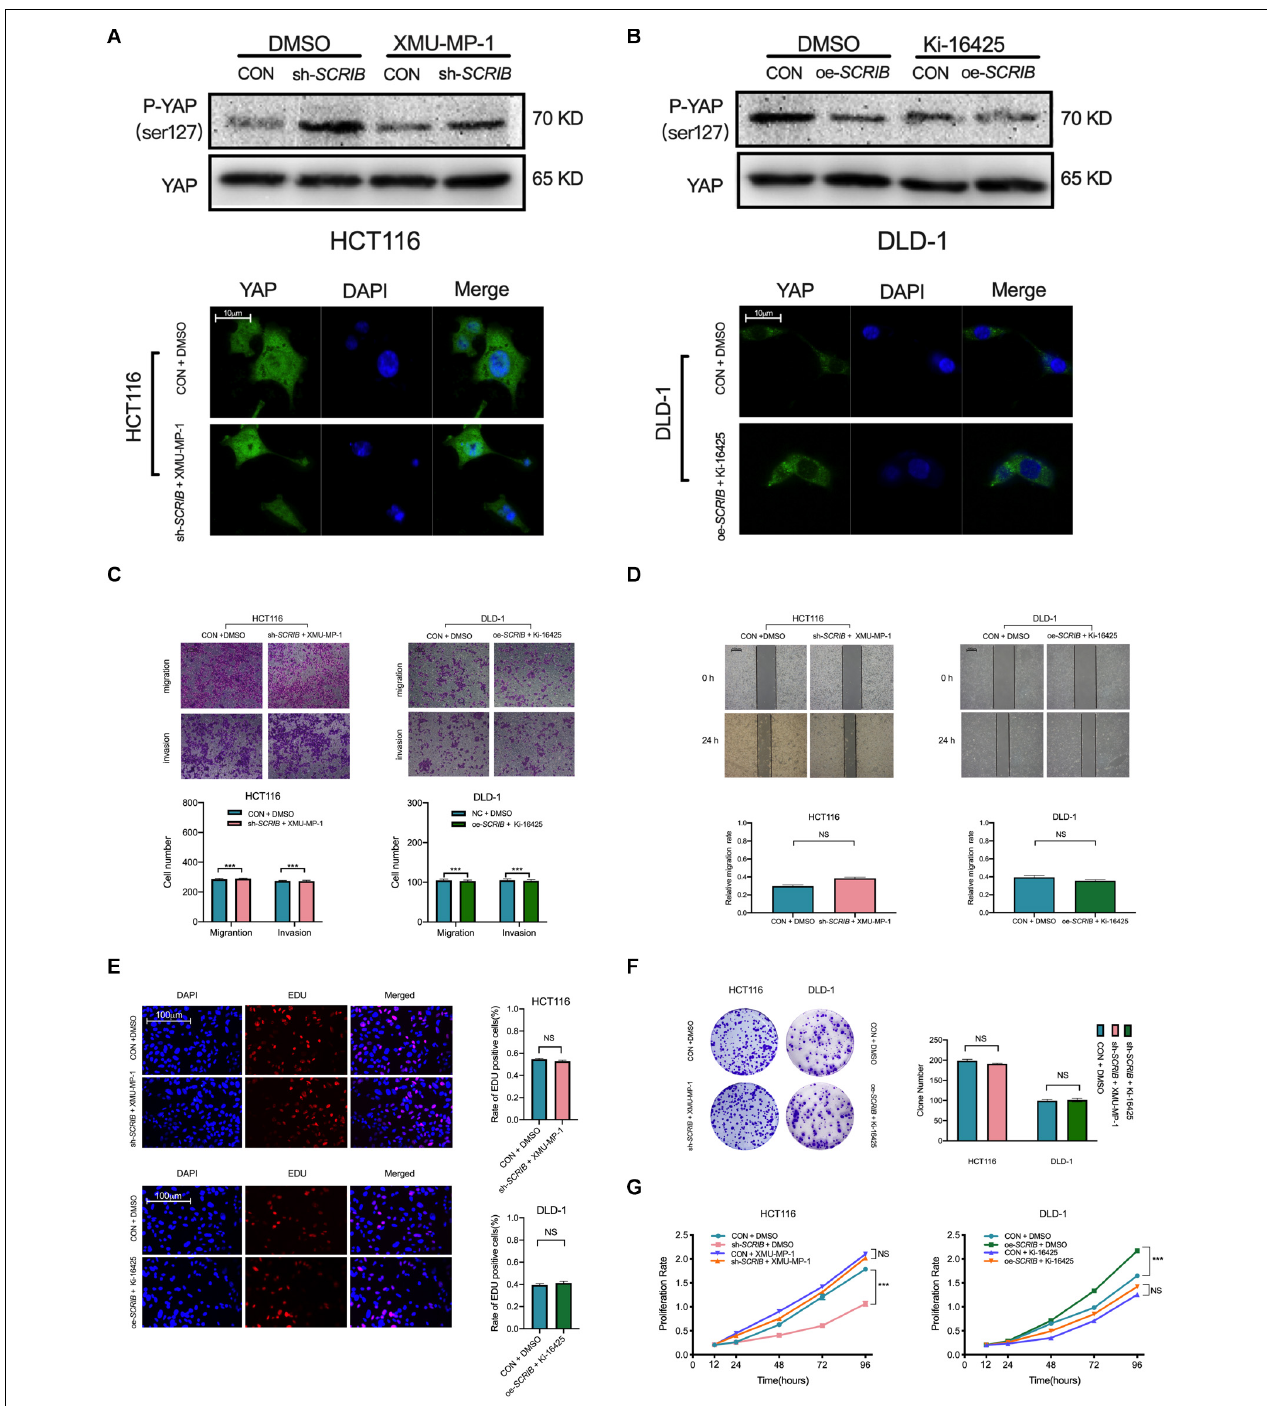
FIGURE 6 | Agonists and inhibitors of the Hippo signalling pathway can restore SCRIB -mediated CRC cell proliferation, invasion and migration. Hippo signalling pathway agonists and inhibitors were used to treat the indicated CRC cells, and the corresponding control cells were treated with DMSO to eliminate errors caused by the drugs. (A) Western blotting was used to detect the phosphorylated YAP (Ser127) and total YAP levels after the cells were treated. (B) Representative images and quantification of immunofluorescence staining for YAP distribution after cells were treated with XMU-MP-1 (1 µ M) and Ki-16425 (2 µ M) for 12 h. (C,D) Cell invasion and migration were detected by Transwell assay and scratch wound healing assay at various time points (ns: no significance). (E–G) Cell proliferation was detected by EdU, colony formation and CCK-8 assays at various time points (*** P < 0.001, ns: no significance).